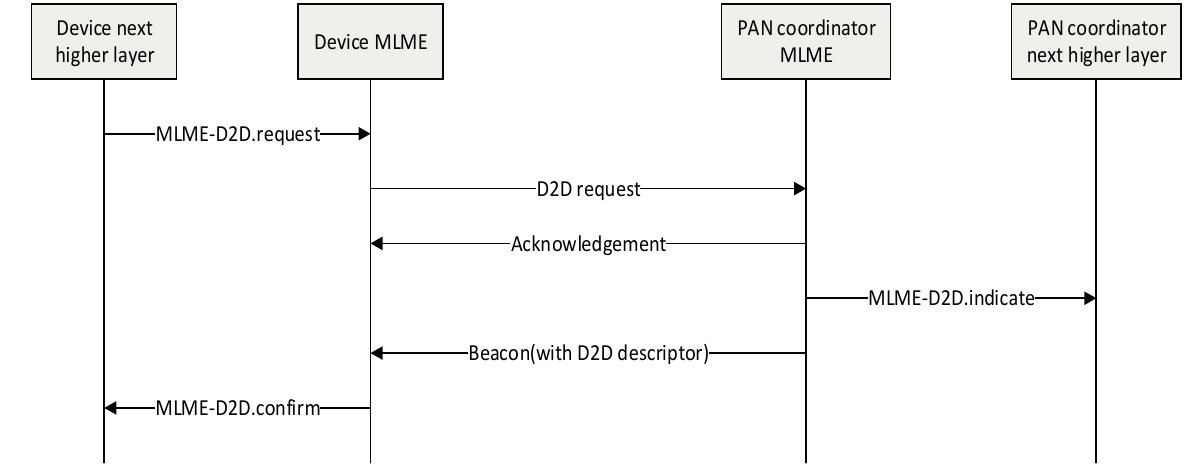
Figure 9. Message sequence chart for D2D allocation initiated by a